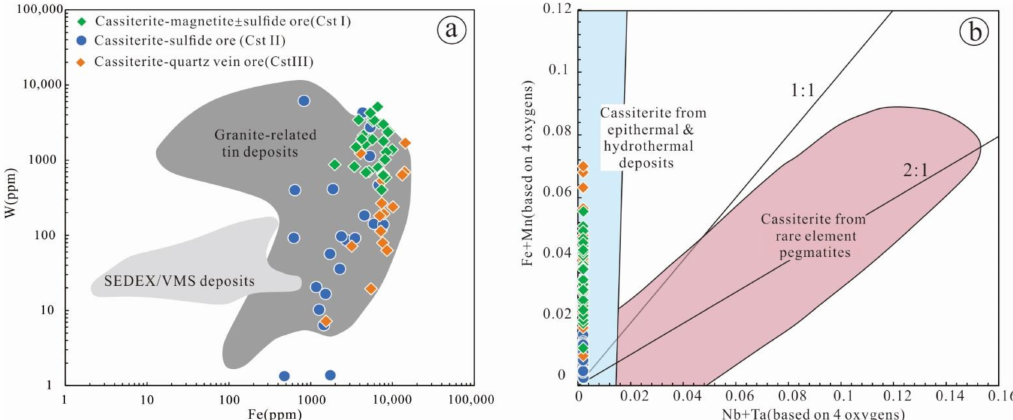
Figure 7. ( a ) Binary plot of Fe vs. W in cassiterite from the Dulong district (modified by [58]). ( b ) Covariation plot of Nb + Ta vs. Fe + Mn in cassiterite grains from the Dulong district (modified by